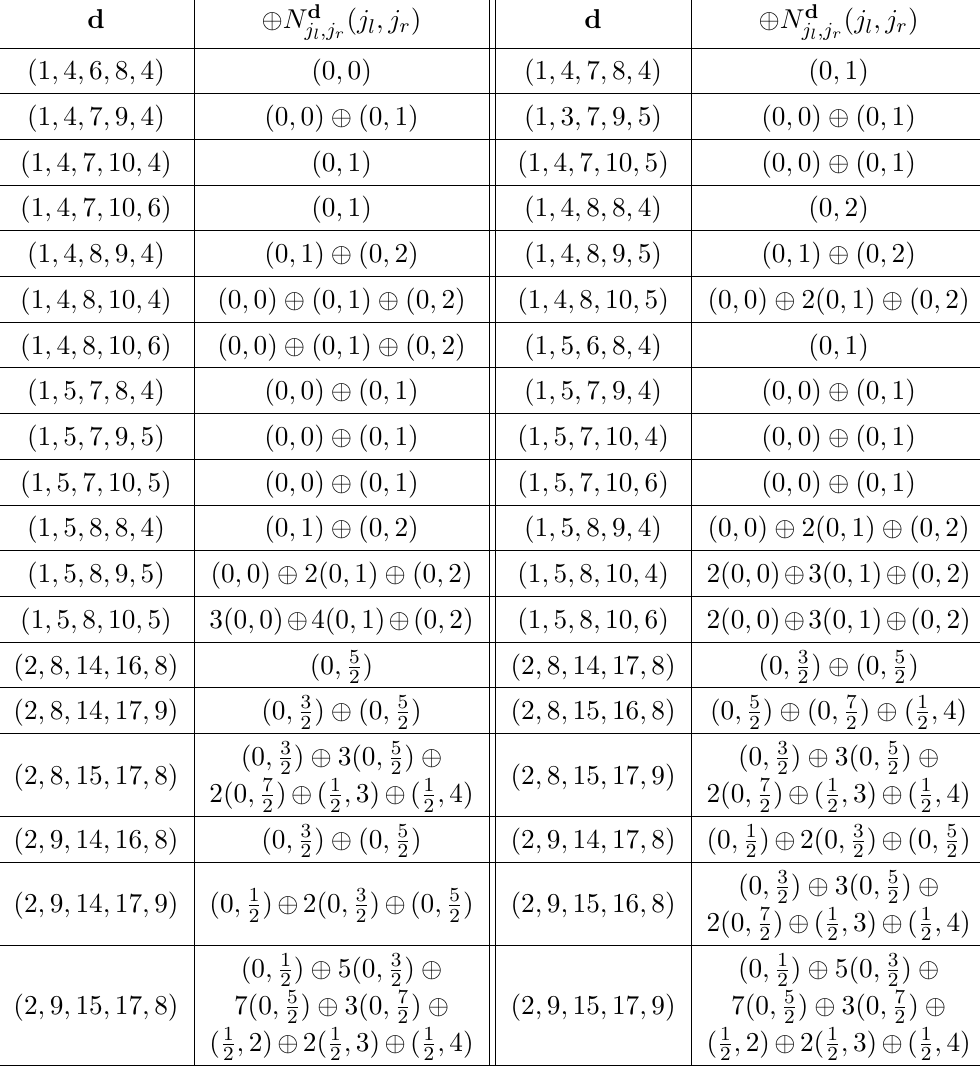
Table 15 . BPS spectrum of the F 4 theory for d 1 = 1 , ( d 2 , d 3 , d 4 , d 5 ) ≤ (5 , 8 , 10 , 6) and d 1 = 2 , ( d 2 , d 3 , d 4 , d 5 ) ≤ (9 , 15 , 17 , 9) . Here, d = ( d 1 , d 2 , d 3 , d 4 , d 5 ) labels the BPS states with fugacity